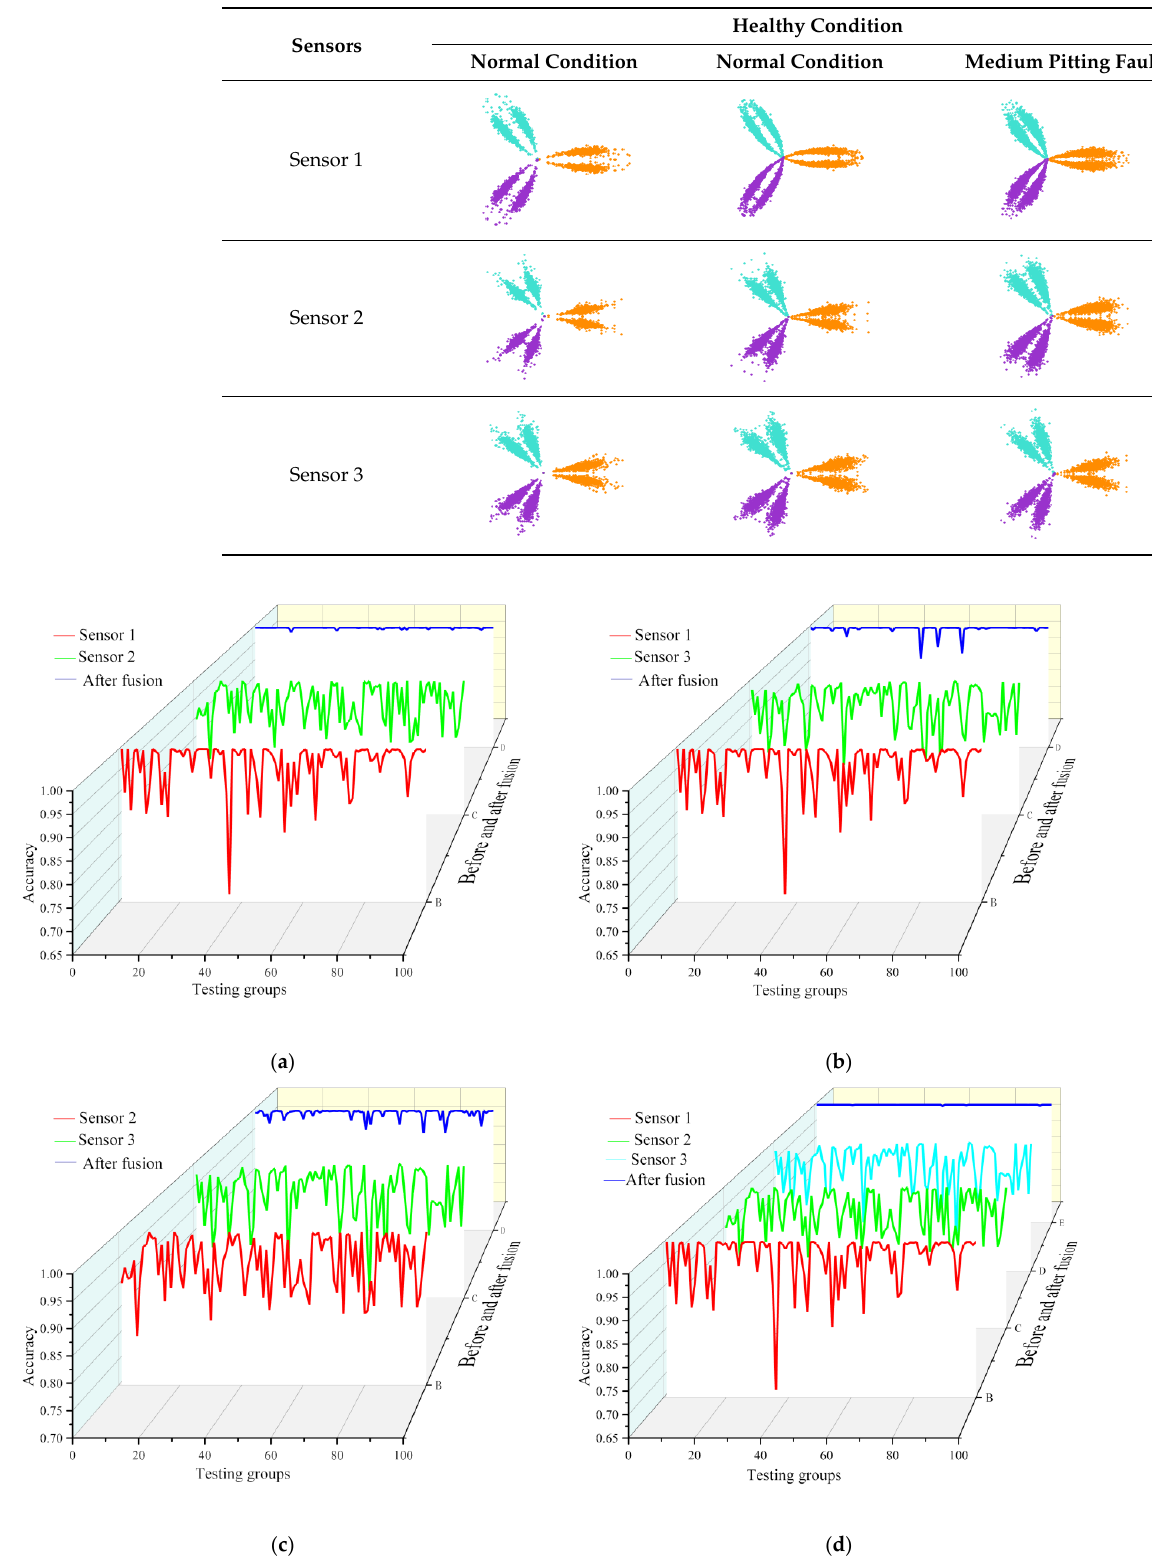
Table 8. Gears with different levels of pitting.